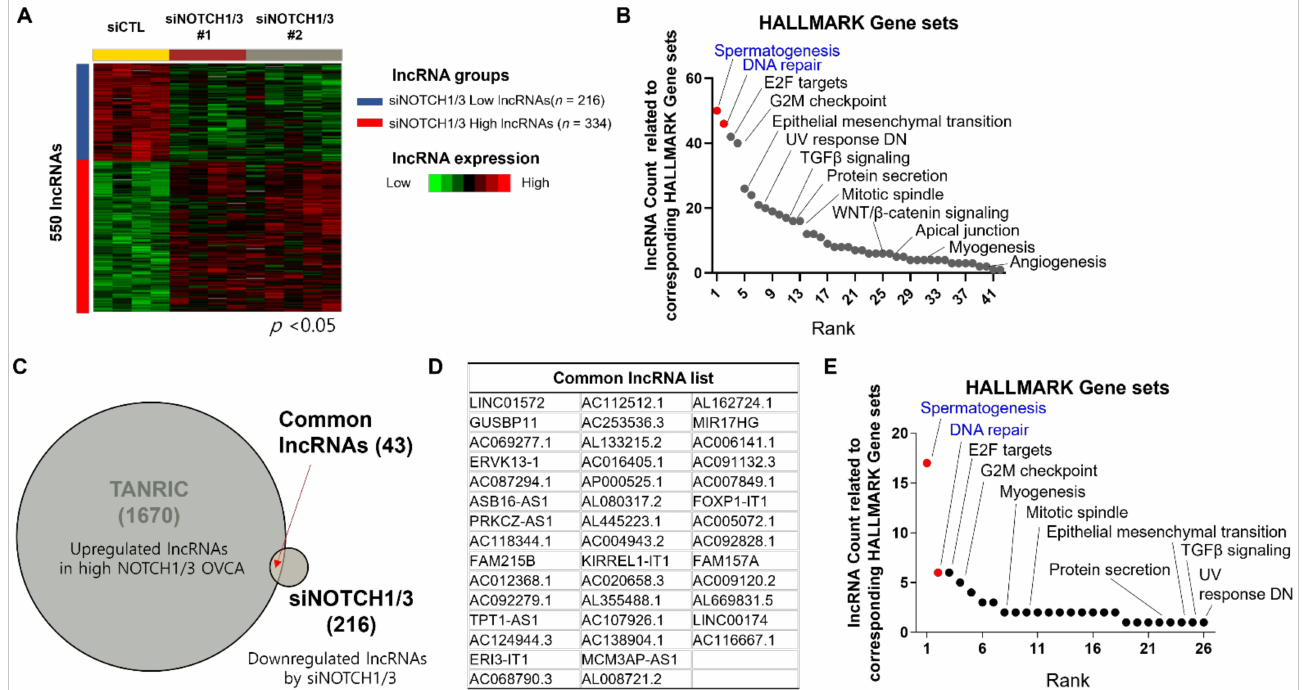
Figure 2. Discovery of Notch-related lncRNAs using transcriptome data from OVCAR3 cells treated with siNOTCH1/3. ( A ) Heatmap showing differentially expressed lncRNAs ( n = 550) according to siNOTCH1/3 treatment. ( B ) Predicted function of Notch-related lncRNAs based on our siRNA experiments using FuncPred. Red coloured dots indicated unique gene sets highly ranked in this analysis, but not in GSEA, as depicted in Figure 1A. ( C ) Venn diagram presenting the logical relation between upregulated lncRNAs in high NOTCH1/3 group in TCGA OVCA and downregulated lncRNAs in our siRNA experiments. ( D ) List of common lncRNAs, as depicted in ( C ). ( E ) Potential function of the common lncRNAs listed in ( D ). Red coloured dots indicate unique gene sets highly ranked in this analysis, but not in GSEA, as depicted in Figure 1A. Abbreviations: TANRIC, The Atlas of Noncoding RNAs in